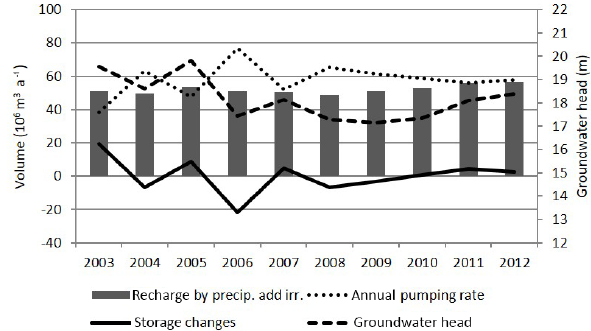
Figure 9. Annual water budget for the period